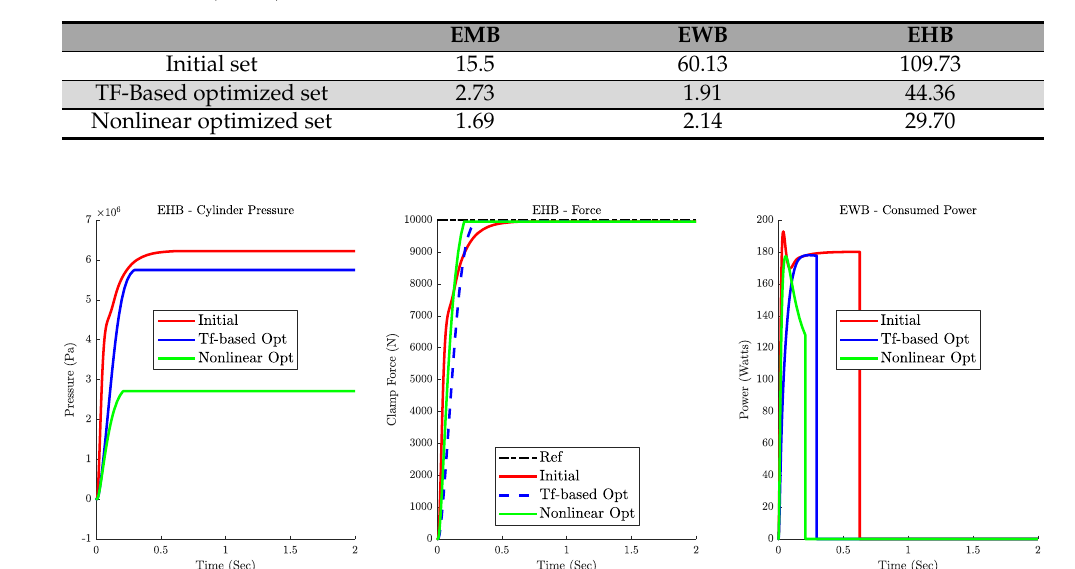
Table 2. Comparison of the amount of energy used in the 10 kN step response for 2 seconds (the amounts are in Joules).